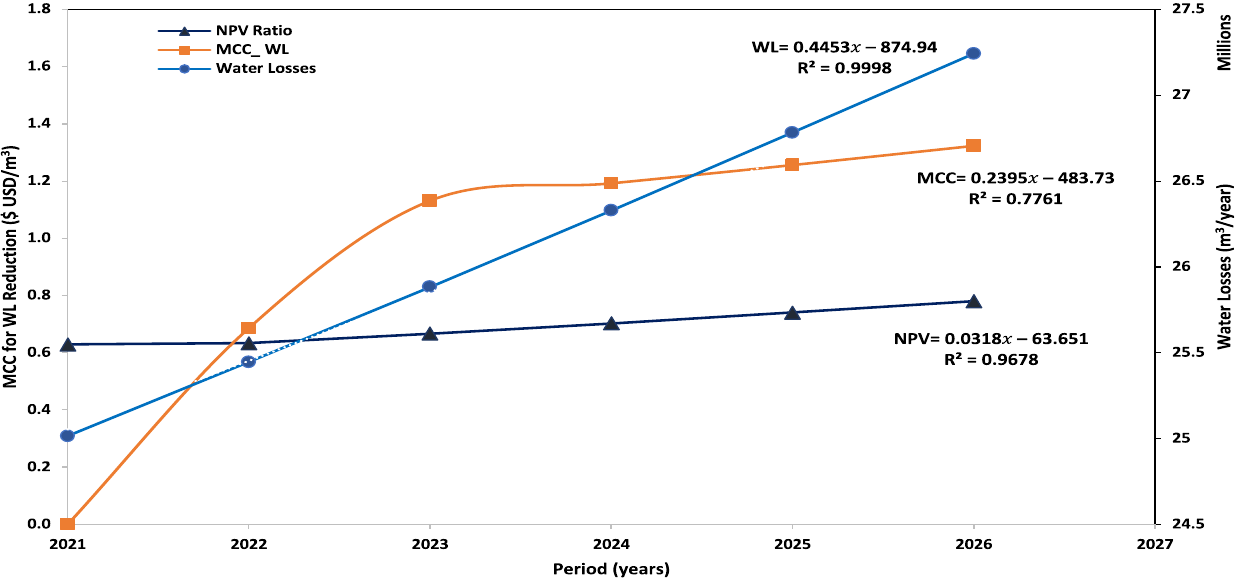
Figure 4. The marginal cost of capital for existing water loss reduction: capital expenditure and operation and maintenance. MCC: marginal cost of capital, WL, water loss, NPV, net present value.